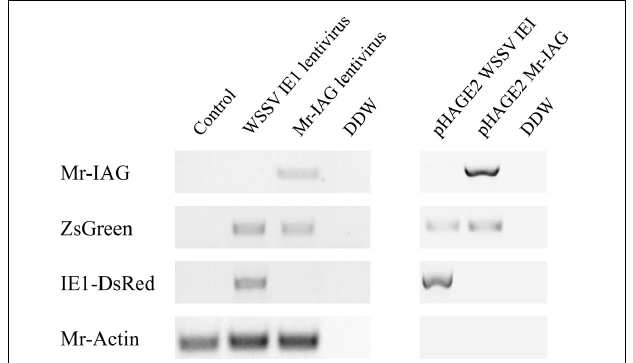
FIGURE 6 | Detection of Mr-IAG sequence in gDNA of M. rosenbergii primary cells. Representation of lentiviral elements ( Mr-IAG , ZsGreen , and IE1-DsRed ) detected in an M. rosenbergii transduced cell culture (representative figure of three replicates). Extractions of genomic DNA were performed 96 h post-transduction (left panel). pHAGE2 WSSV IE1 and pHAGE2 Mr-IAG vectors served as the positive control for lentiviral sequences (right panel). Mr-Actin served as the positive control for M. rosenbergii cell cultures.